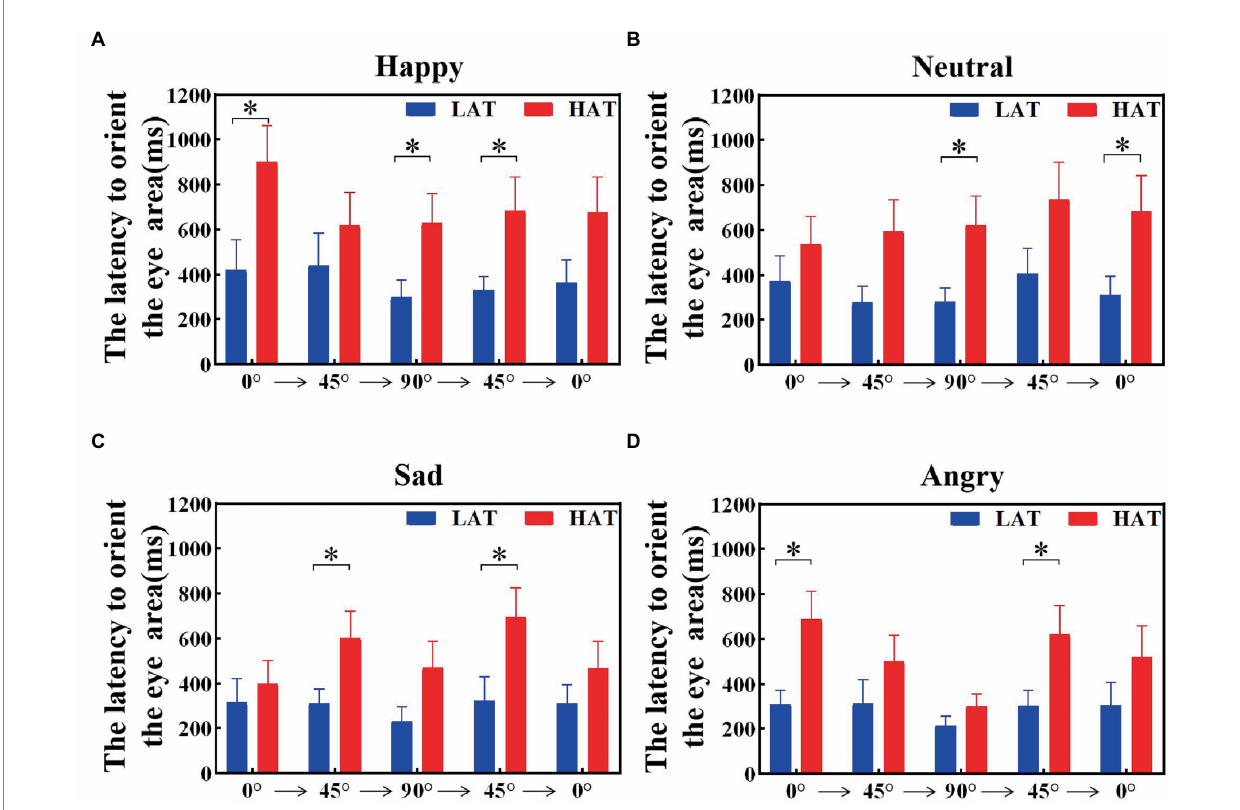
FIGURE 6 The latency to orient the eye area of the HAT and the LAT groups during the observation of happy (A) , neutral (B) , sad (C) , and angry (D) emotional faces with different angles under the ‘Front-Side-Front’